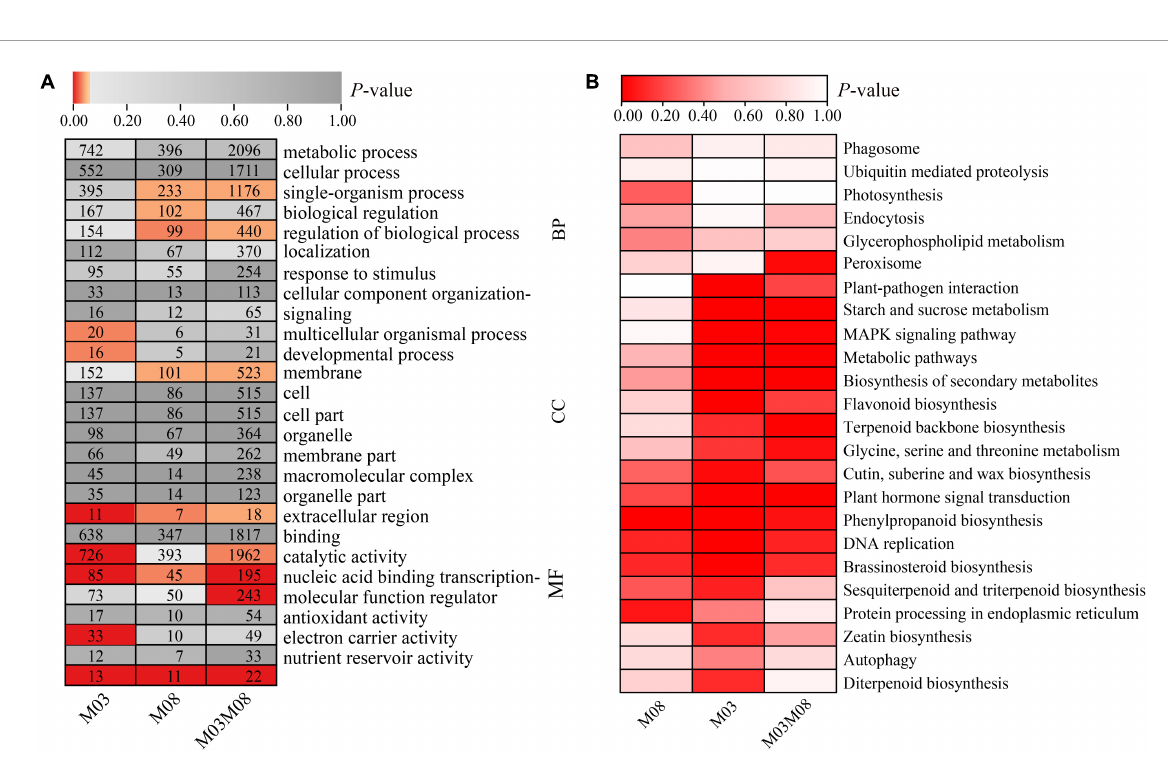
FIGURE5 GO and KEGG pathway analysis of DEGs. (A) GO annotation of DEGs. In each block of the heatmap, the number represents the gene numbers, and the red coloring represents a P -value of ≤ 0.05. (B) KEGG pathway analysis of DEGs. GO terms and KEGG pathway enrichment with P -value ≤ 0.05 were identified as significantly